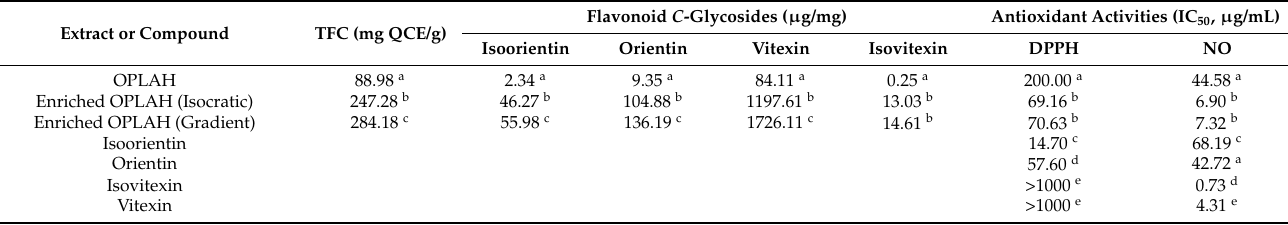
Table 4. Quantification and free radical scavenging activities of flavonoid C -glycosides in OPLAH, enriched OPLAH fractions and individual